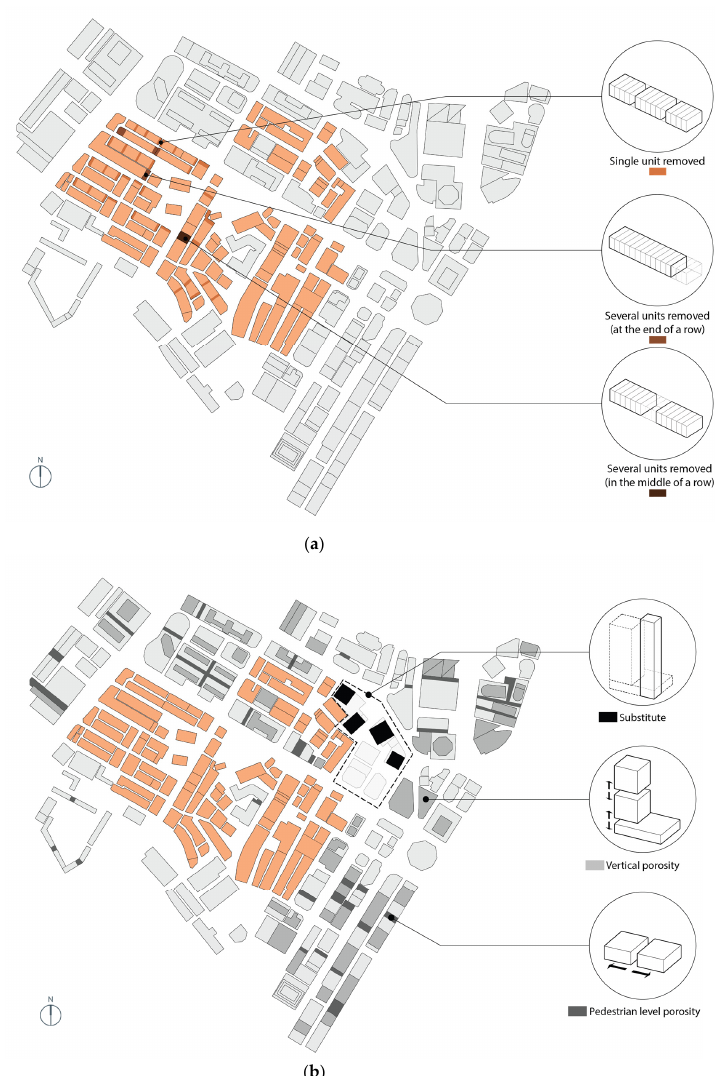
Figure 12. ( a ). Mitigation strategies description for historic shophouses in Chinatown. ( b ). Mitigation strategies description for surrounding high-rise buildings Comparing the three mitigated cases with the real scenario, Case E, the results showed that all the three cases with mitigation strategies had decreased temperature